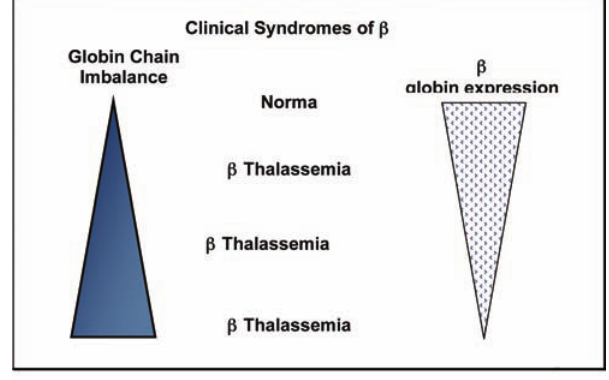
Figure 1. Correlation between globin chain imbalance, globin gene expression and clinical